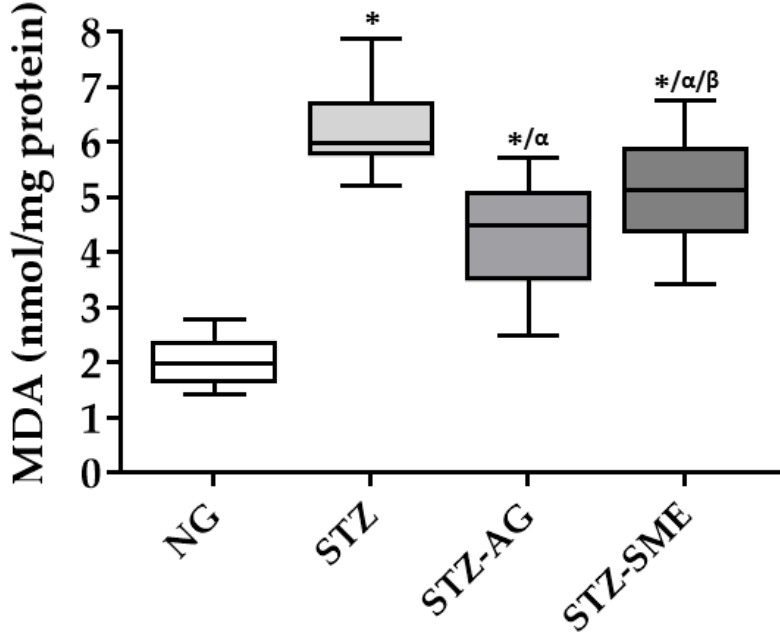
Figure 3. Antioxidant effect of SME in the diabetic retina determined by lipid peroxidation. Malondialdehyde (MDA) levels in the NG, STZ, STZ-AG, and STZ-SME groups were analyzed. Concentrations are shown in the box-and-whisker plot. * p < 0.01 compared to NG; α p < 0.01 compared to STZ; and β p < 0.05 compared to STZ-AG.